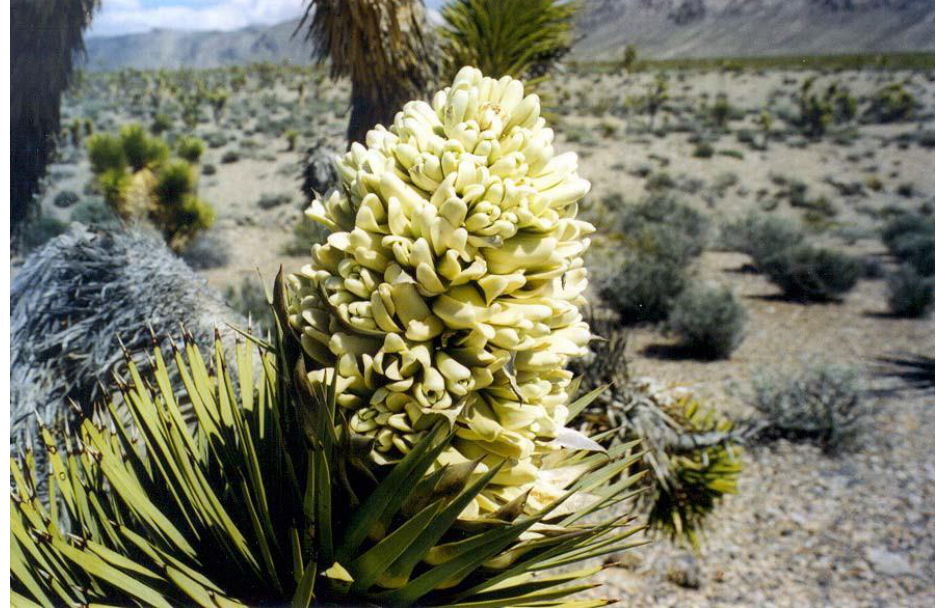
Figure 21. Joshua Tree (Yucca brevifolia ) flower and fruit (Source: Stoffle).